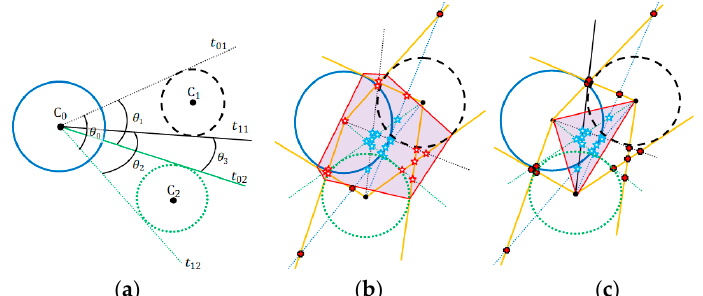
Figure 11. ( a ) Illustrations that define the Tangent Lines with Minimal Angles Model (MAI). ( b ) All intersections (red-star) with non-minimal angle tangent lines (orange-lines) must be eliminated. ( c ) All points inside the ROI formed by the convex hull polygon among the circle centers are the required points (blue-star).